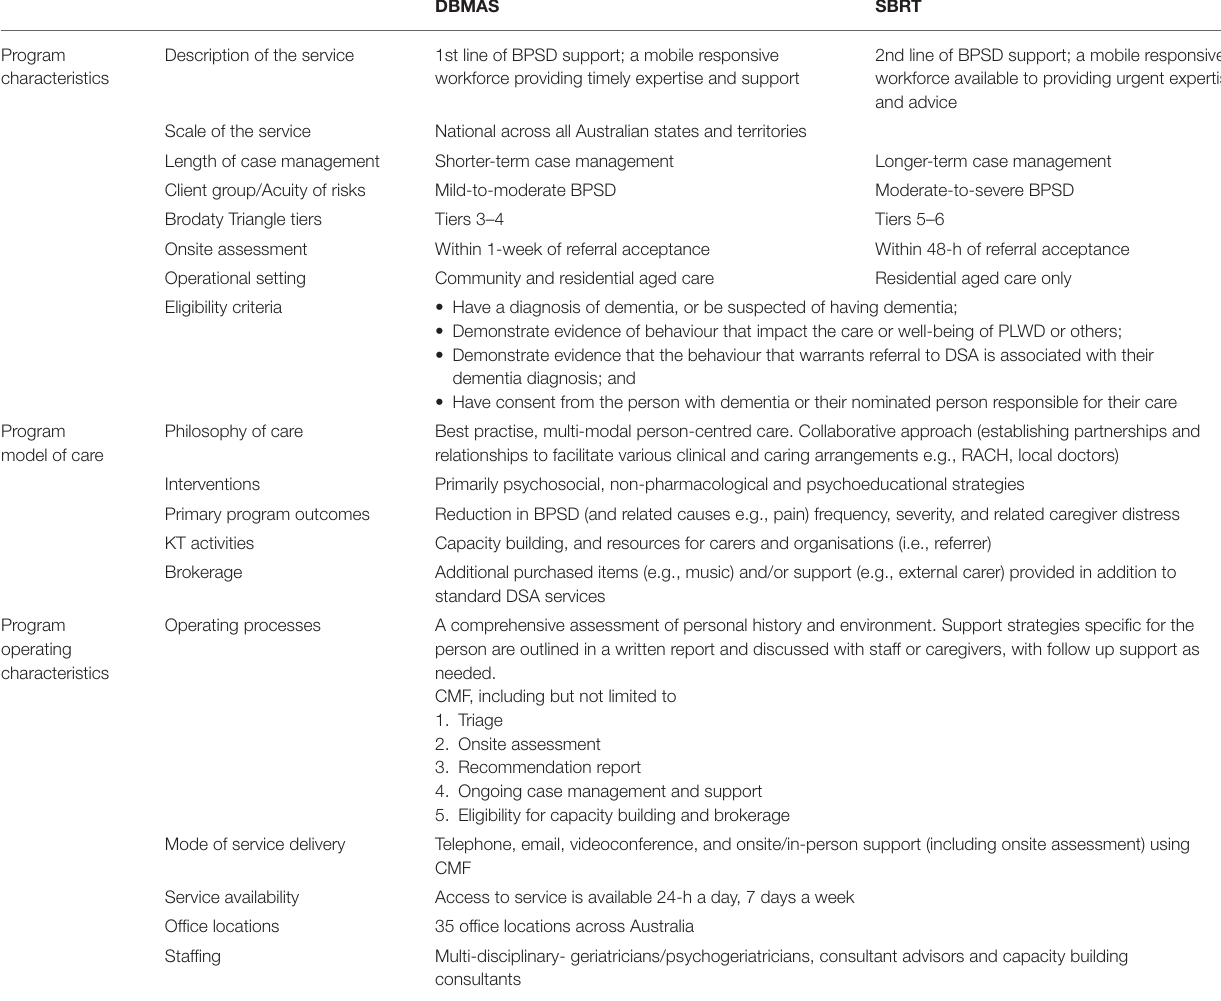
TABLE 1 | Key features of “DSA” DBMAS and SBRT